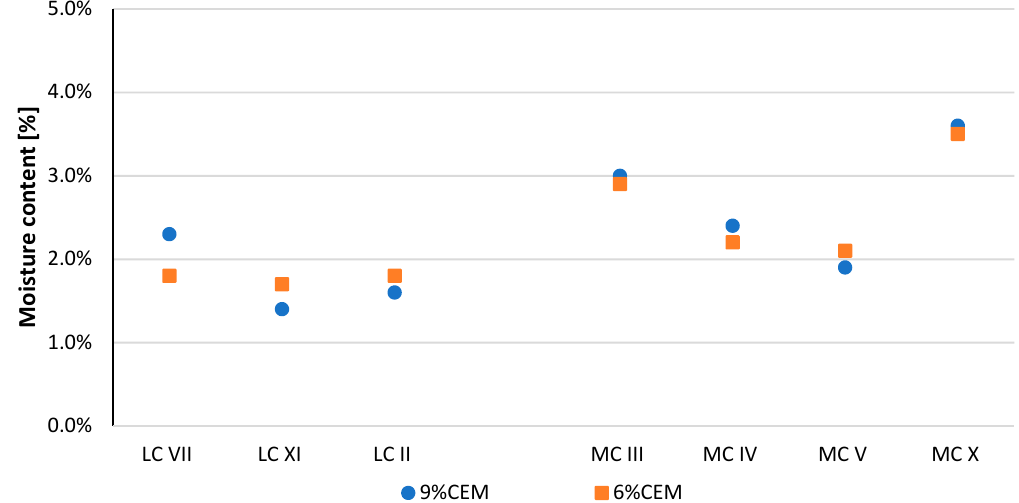
Figure 9. Average moisture content of each CSRE sample series during the compressive strength tests.